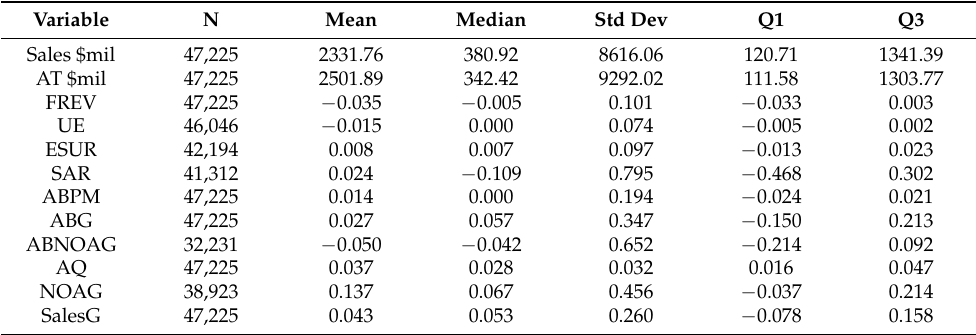
Table 2. Sample Descriptive Statistics a